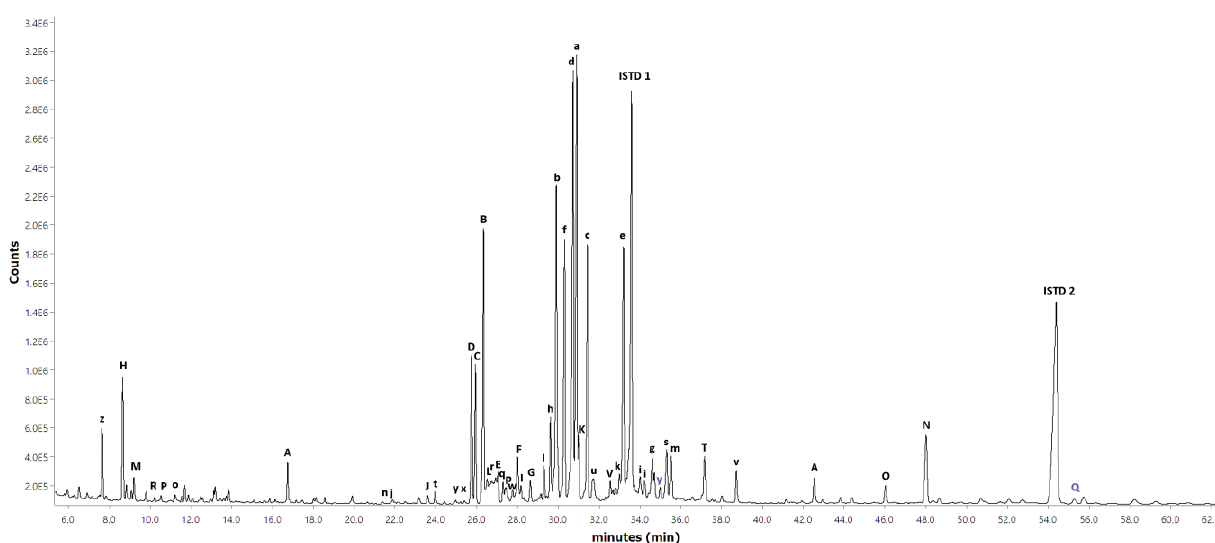
Figure A1. Reference gas chromatography with flame ionisation detection or mass spectrometry (GC-FID/MS) chromatogram for hexane extract of spruce bark. For alphabetical peak symbols, see Table 3.